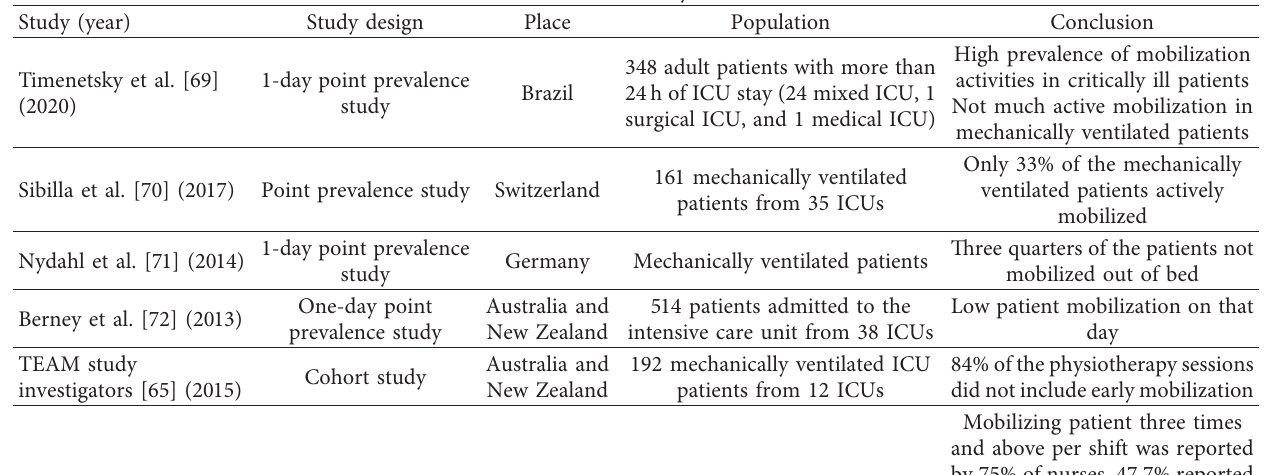
Table 9: Practice of early